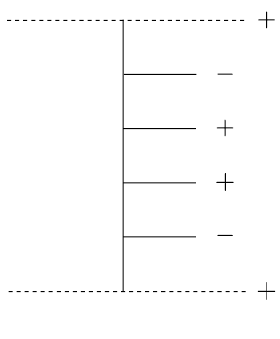
Figure 3 . Region % 8 ; 1